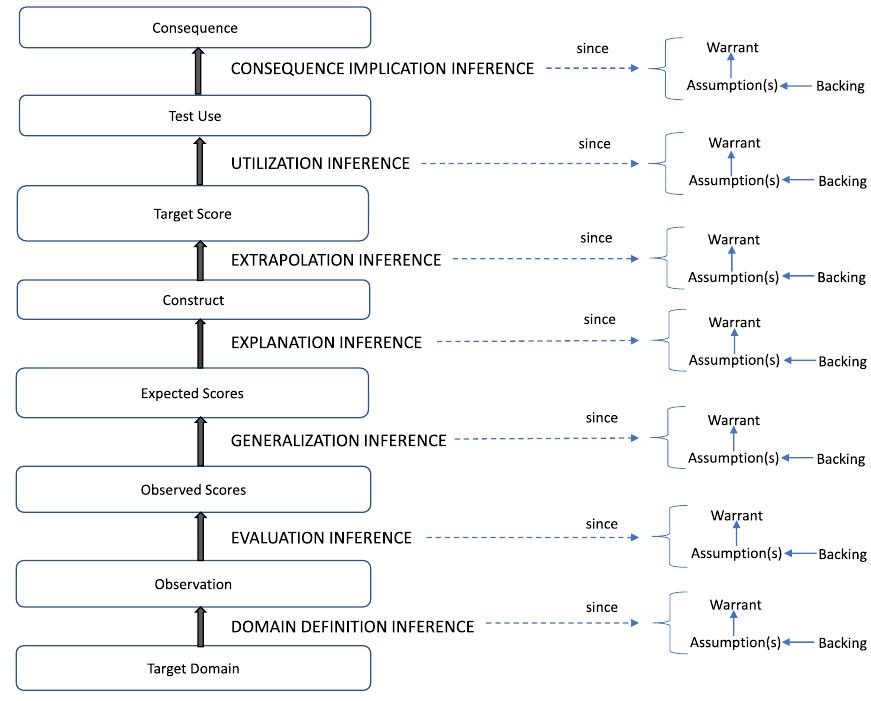
Fig. 1 An outline of an I/UA for a language